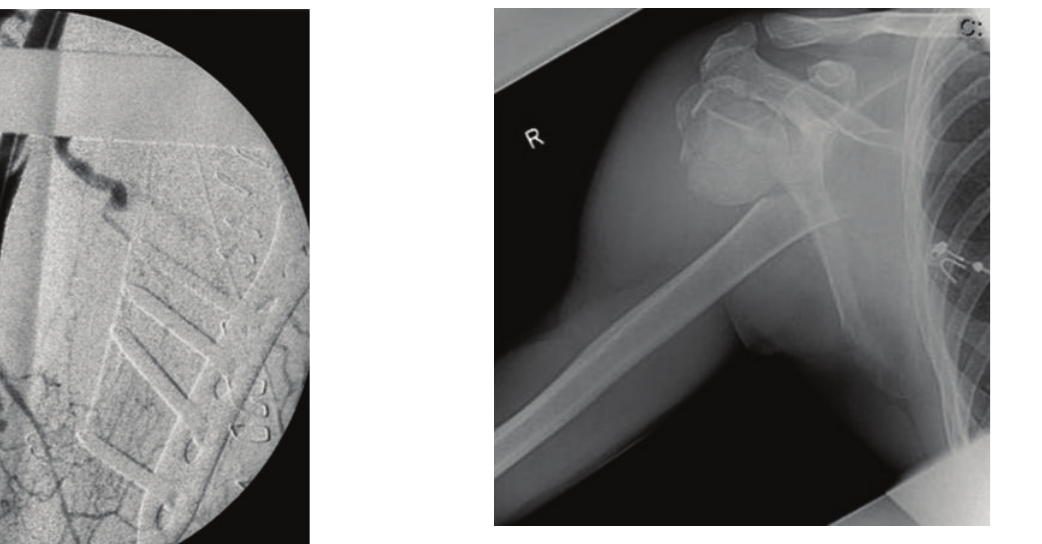
was weak or absent, respectively, dependent on the position of the right arm.